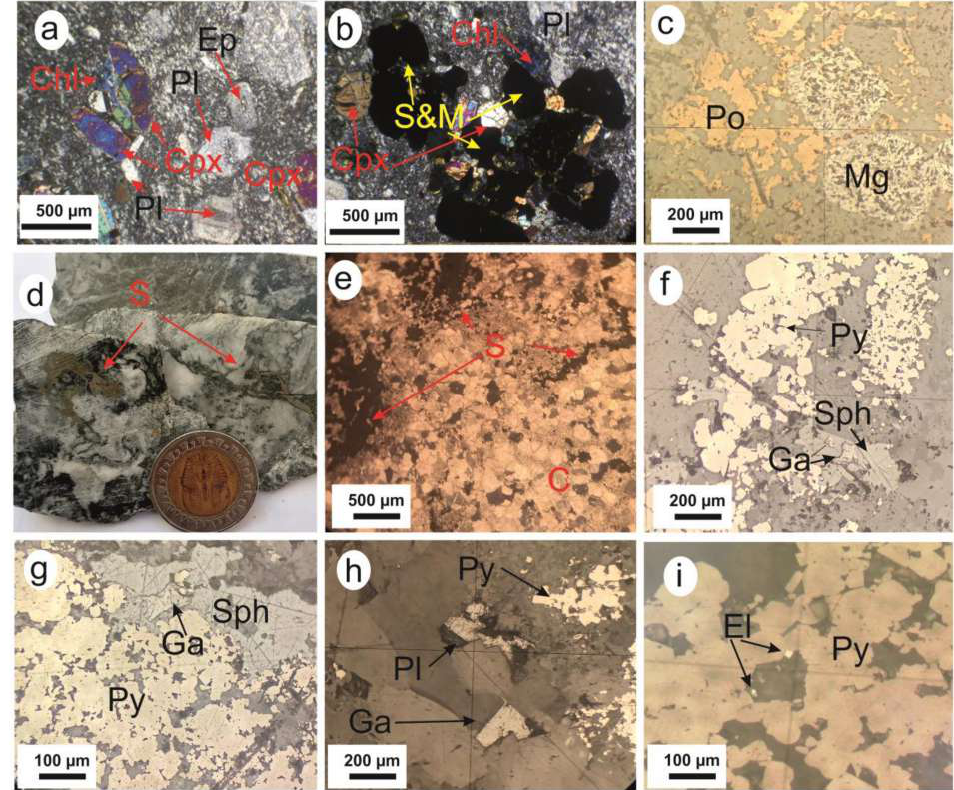
Figure 14. ( a ) Mineral composition of metabasalt, showing clinopyroxene (Cpx) and plagioclase (Pl) phenocrysts, with chlorite (Chl) and epidote (Ep) as secondary minerals, embedded in a fine groundmass with porphyritic texture. ( b ) Clinopyroxene and plagioclase phenocrysts with opaque aggregates of sulfides and magnetite set in a fine groundmass. ( c ) Anhedral grains of pyrrhotite (Po) and euhedral magnetite (Mg). ( d ) Slab of carbonate rock with sulfide (Slf) veinlets from the core sample. ( e ) Sulfide (Slf) veinlets in carbonates (C). ( f , g ) Irregular contact between pyrite (Py) and sphalerite (Sph). ( h ) Isolated anhedral polybasite grains hosted in carbonate minerals. ( i ) Electrum (El) specks at the boundary of pyrite and carbonate minerals and as inclusions in the latter. ( a , b , e ) are ordinary optical microscope photos; ( c , f – h , i ) are reflected-light microscopy